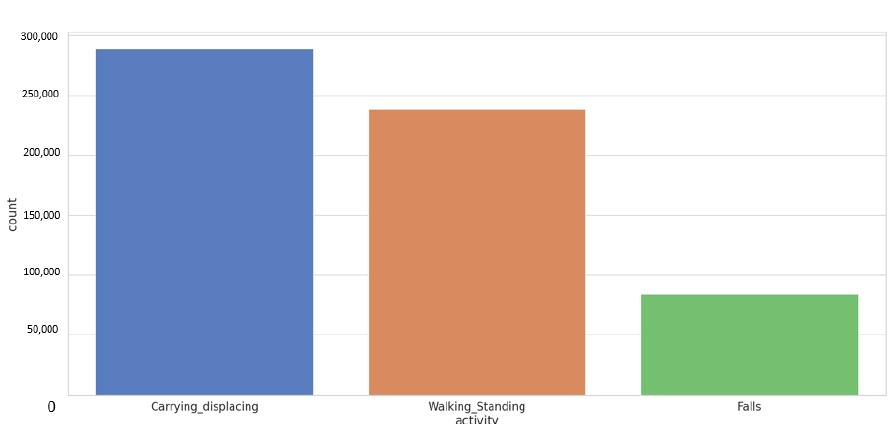
Figure 13. Histogram diagram of number of samples by class.